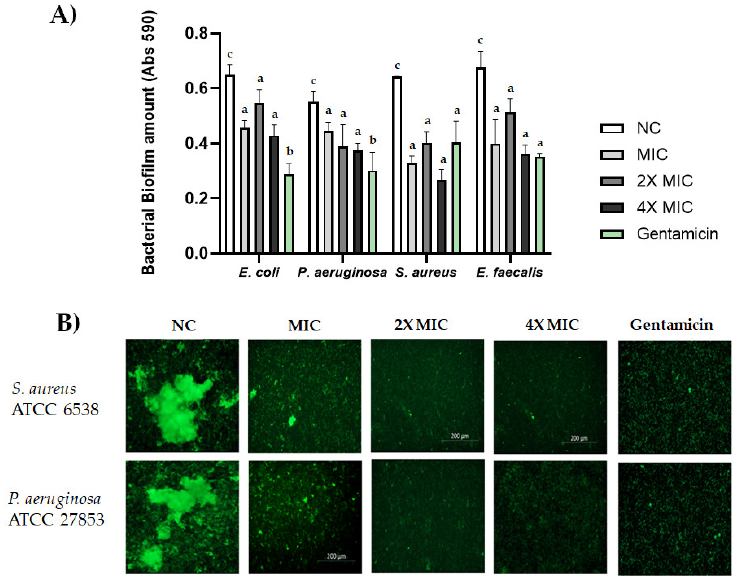
Figure 5. ( A ) Activity of CBDA against biofilms of E. coli ATCC 13762, S. aureus ATCC 6538, P. aeruginosa ATCC 27853 and E. faecalis ATCC 29212. CBDA was tested for inhibition of biofilm formation at concentrations corresponding to MIC, 2X MIC and 4X MIC against E. coli ATCC 13762, S. aureus ATCC 6538, P. aeruginosa ATCC 27853 and E. faecalis ATCC 29212. NC: negative control. Gentamycin (0.2 µ g/mL) was used as positive control. Data were expressed as the mean ± SD of three individual experiments. Multiple comparisons were performed by ANOVA. Different letters (a, b, c) indicate significant differences at p < 0.05 analyzed by ANOVA. ( B ) Biofilms of S. aureus ATCC 6538 and P. aeruginosa ATCC 27853 were grown in 24-well plates for 24 h in the absence (NC) or presence of CBDA and stained with the LIVE/DEAD bacterial biofilm kit (SYTO-9 staining).